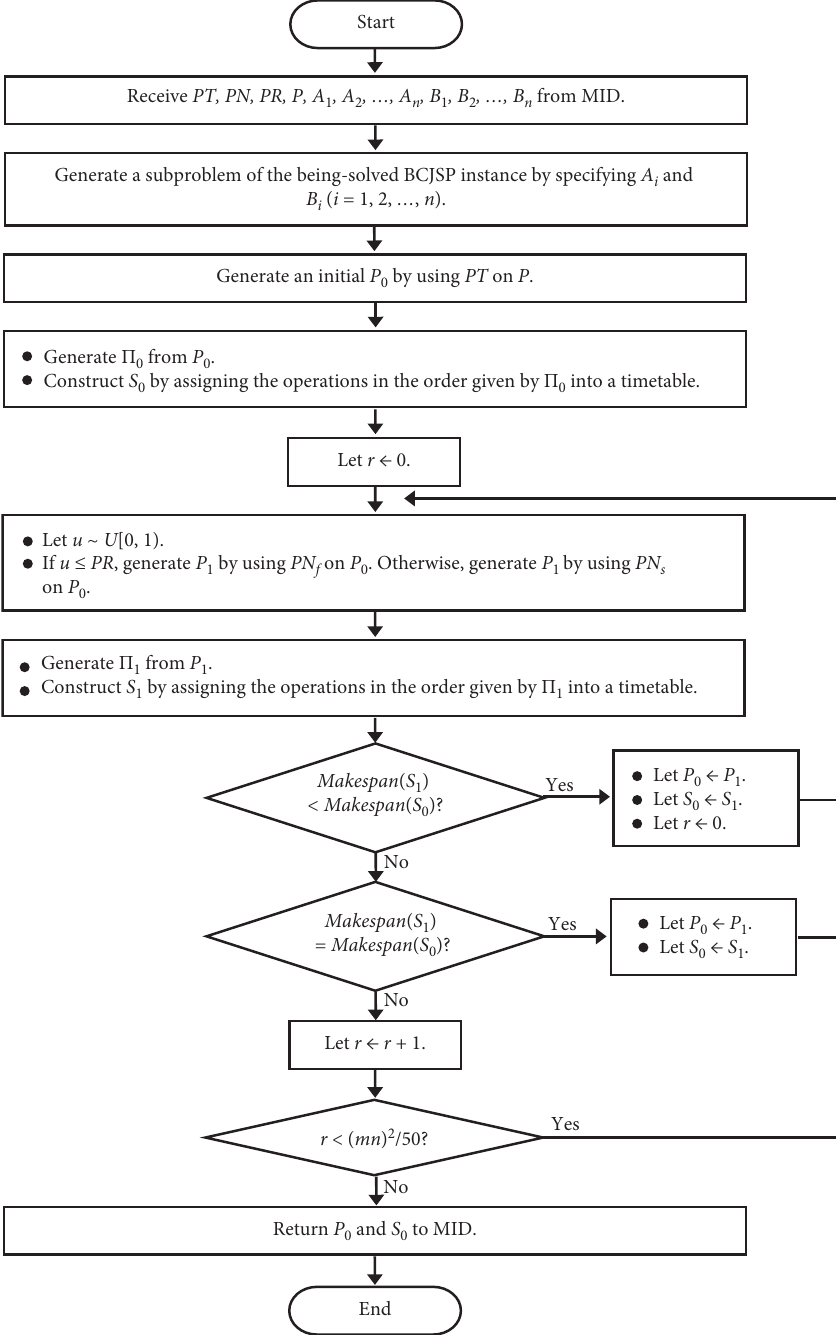
Figure 2: A flowchart of